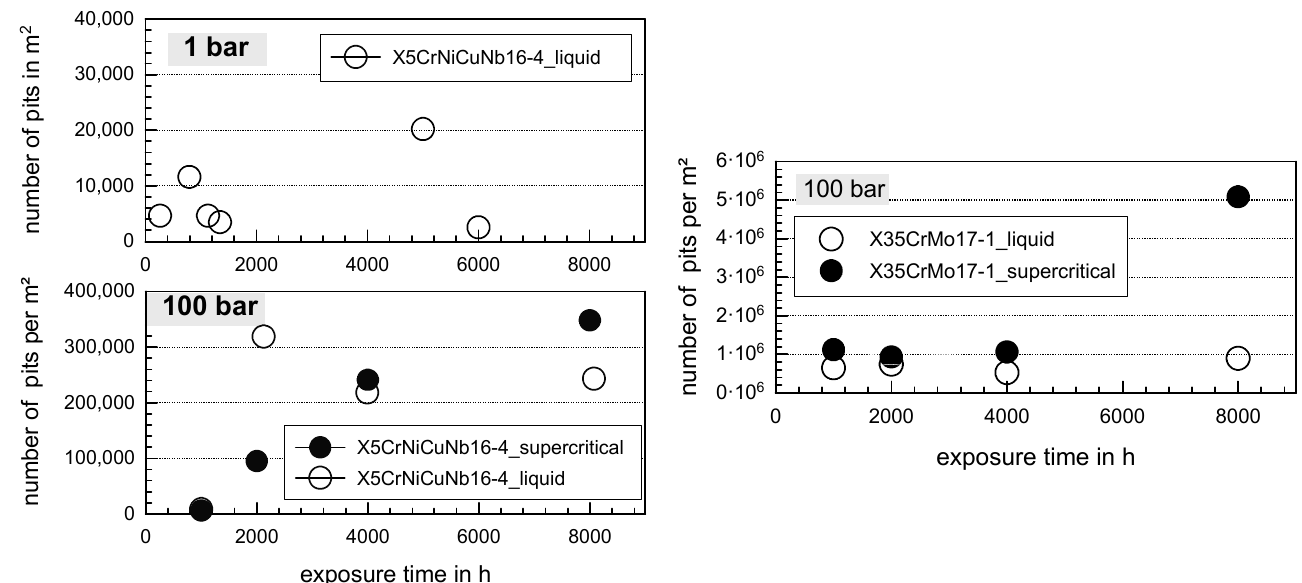
Figure 7. Number of pits of X20Cr13 in the liquid phase after 6000/8000 h of exposure to aquifer brine water at 60 °C and ambient pressure, as well as at 100 bar. ( Up left ): X20Cr13, ( up right ): X46Cr13, ( down left ): X35CrMo17-1, ( down right ): X5CrNiCuNb16-4.